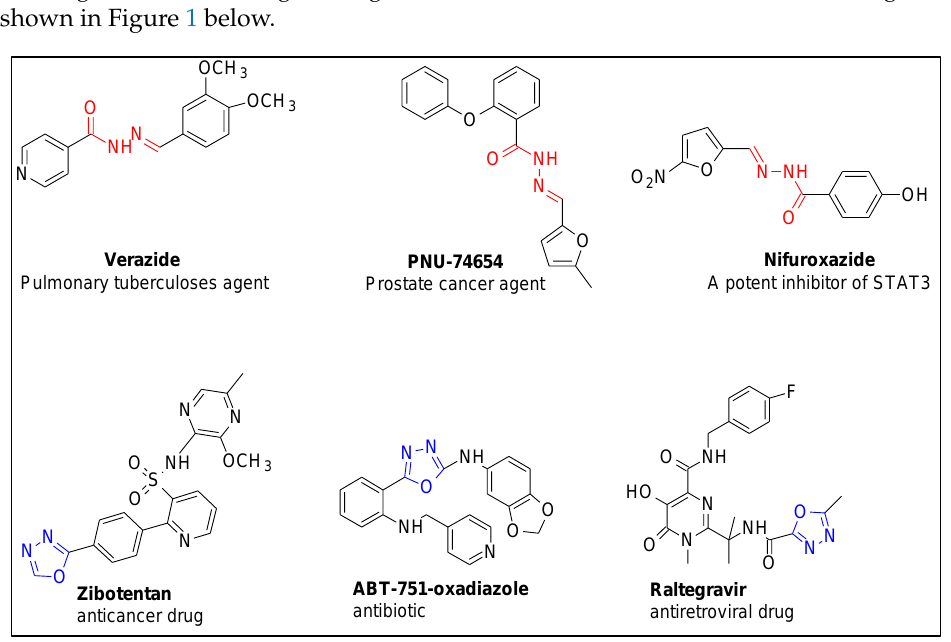
Figure 1. Structures of some hydrazones and 1,3,4-oxadiazoles used as pharmaceutical drugs in the clinic.